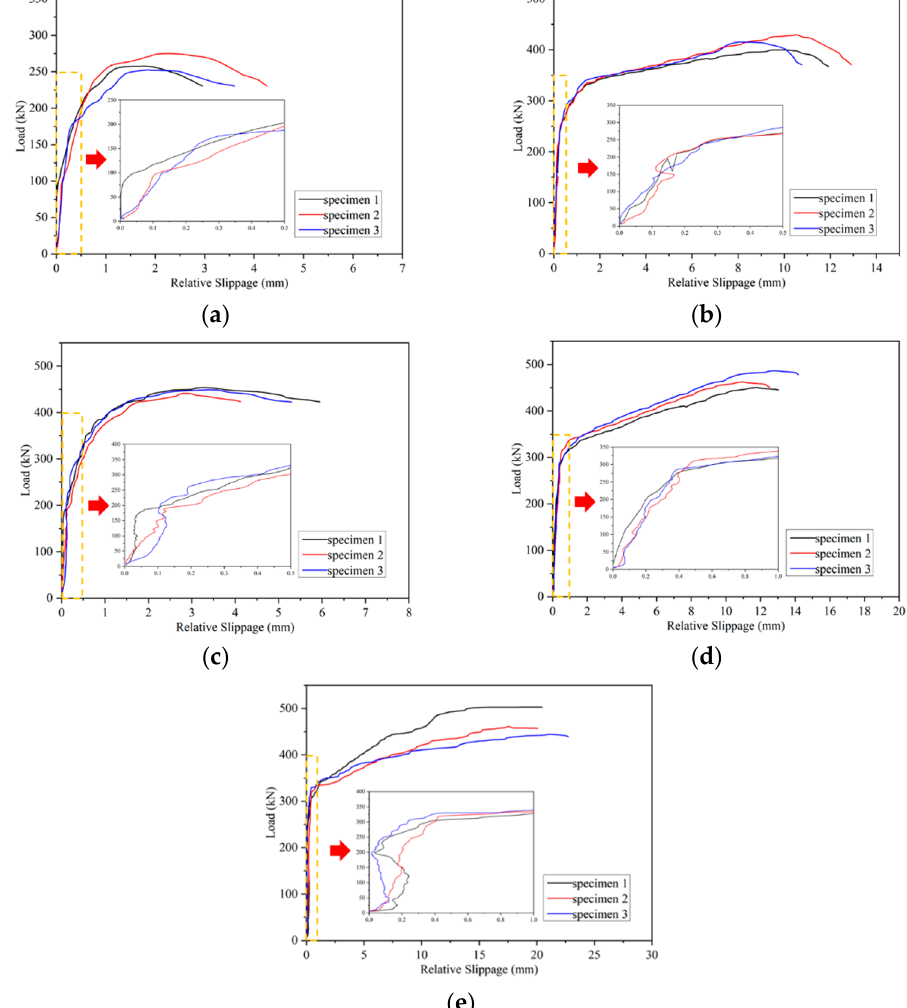
Figure 8. Load-relative slip curves ( a ) PR-S-1.5d; ( b ) PR-S-2d; ( c ) PR-H-2d; ( d ) PR-S-2.5d; ( e ) PR-S-3d.